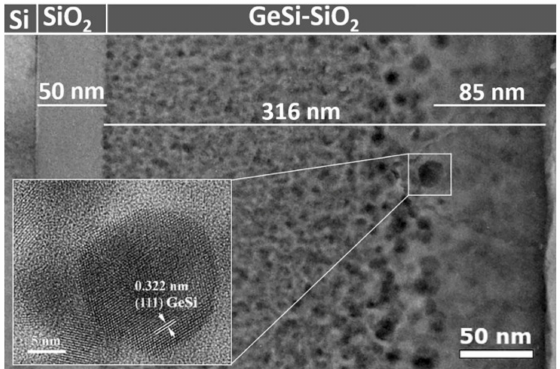
Figure 2. Low magnification XTEM image of GeSi NCs:SiO 2 / SiO 2 / n-Si structure. Inset is an HRTEM image of a spherical GeSi NC.